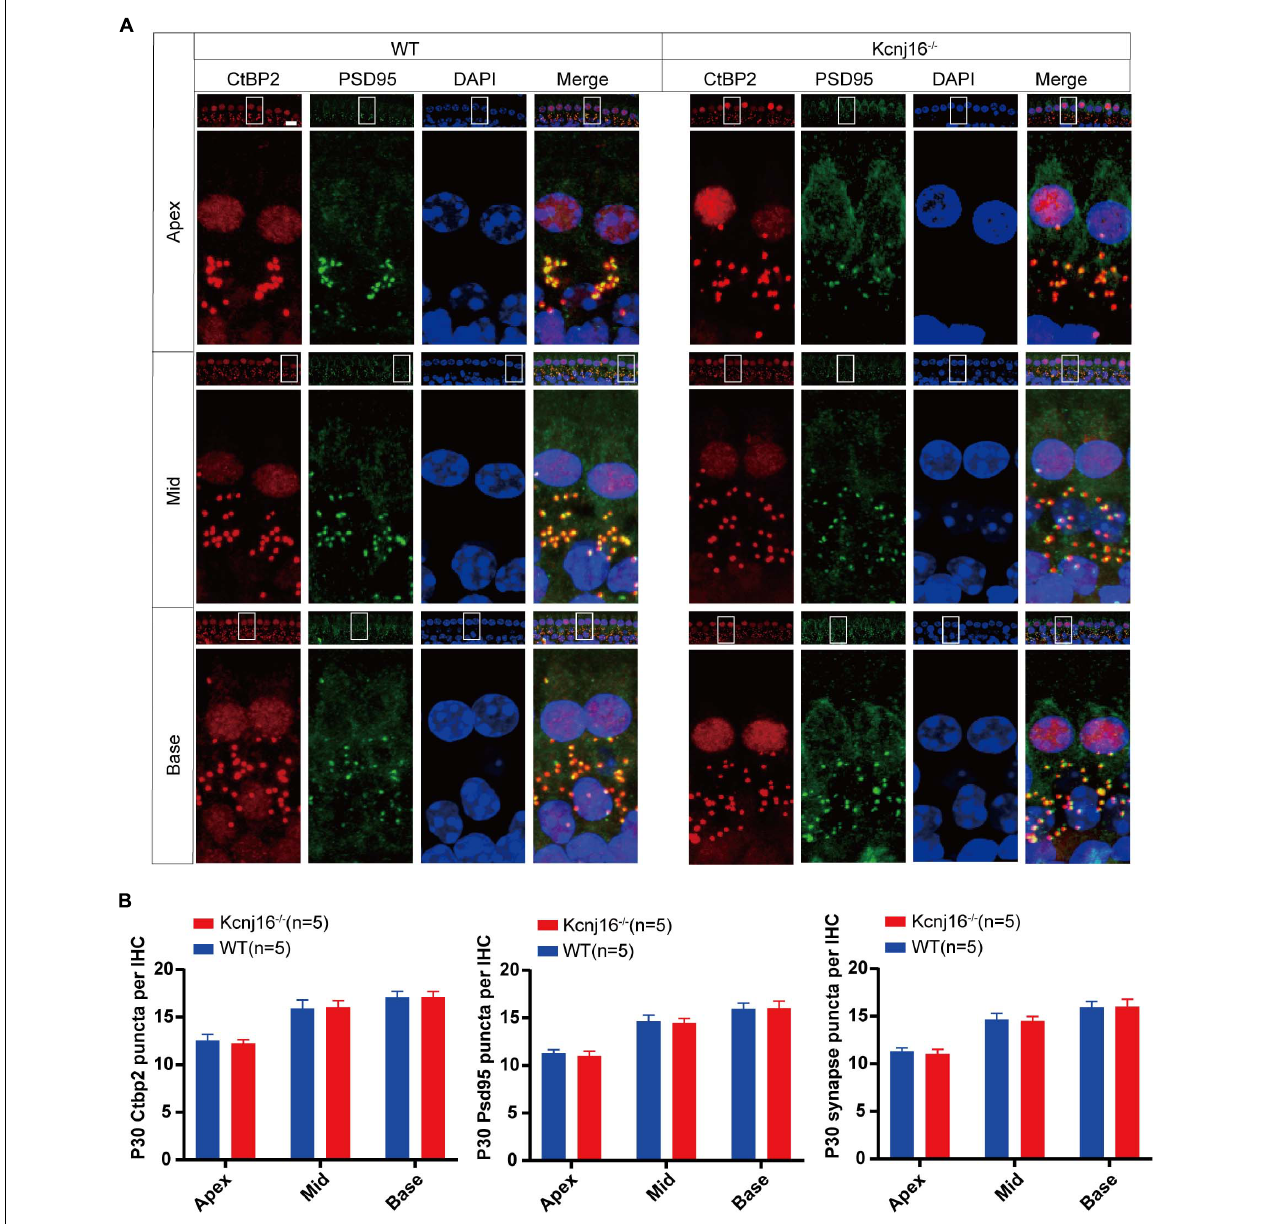
FIGURE 7 | The morphology of IHC ribbon synapses is preserved in Kcnj16 − / − mice. (A) Ribbon synapses of P30 Kcnj16 − / − and WT mice were stained with the ribbon synapse-specific markers CtBP2 and PSD95 and imaged under a confocal microscope. Scale bar = 10 µ m. (B) The total numbers of CtBP2 and PSD95 puncta and synapses from the apical to basal turns were counted and compared between WT and Kcnj16 − / − mice. No significant differences were seen for any measurements ( p > 0.05, n = 5). Data are presented as the mean ±